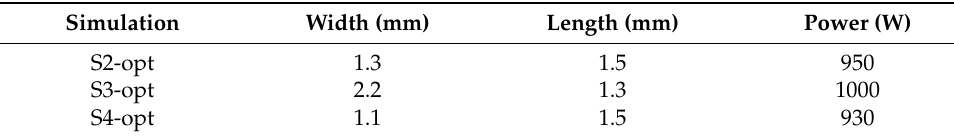
Figure 11. Longitudinal and cross-sections of simulation S4-opt, where a secondary laser beam was added to the conditions of EX4 and iteratively optimized. All measurements in (mm). Table 3. Optimal secondary beam